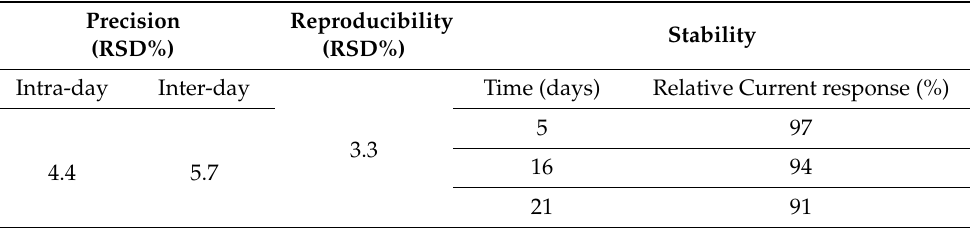
Table 7. Precision, reproducibility, and stability of the PPy/FeCN-SPCE sensor.